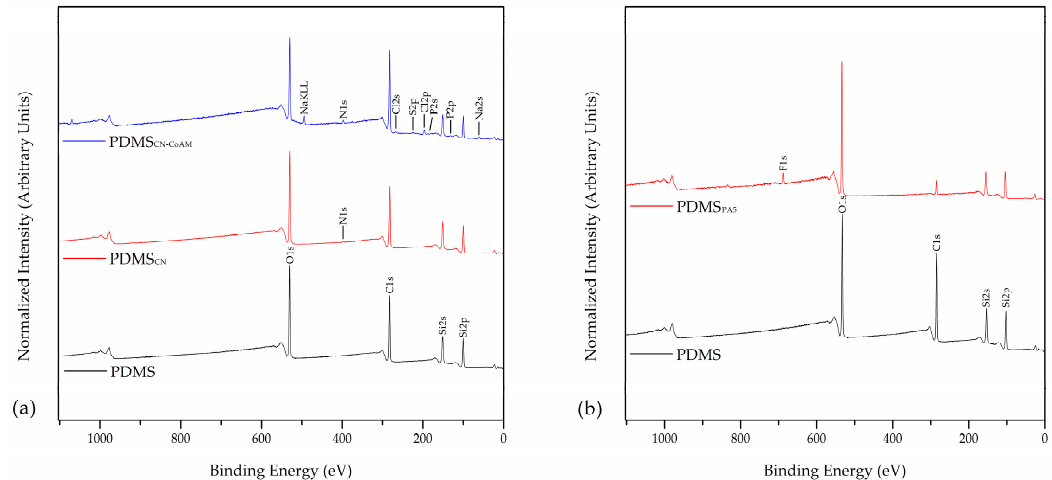
Figure 1. Binding energy peaks of elements of neat inactivated silicone PDMS, PDMS CN and PDMS CN-CoAM ( a ). Binding energy peaks of elements of PDMS and O 2 plasma (PDMS PA5 ) activated silicone ( b